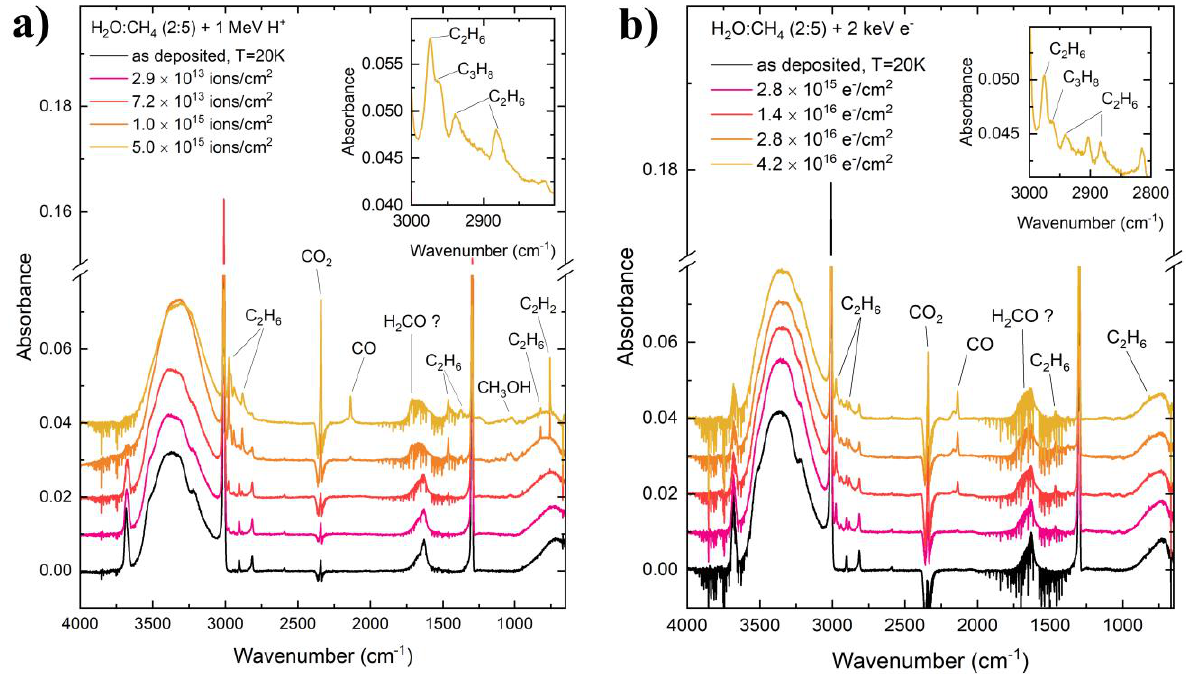
Figure 2. Mid-infrared absorption spectra of CH 4 :H 2 O (= 5:2) mixed ices upon preparation at 20 K and during irradiative processing using ( a ) 1 MeV protons and ( b ) 2 keV electrons. The absorption bands of various daughter molecules have been labelled. Note that the fine structures and negative absorptions in the regions of the H 2 O and CO 2 bands are due to variations in the concentrations of atmospheric gas-phase H 2 O and CO 2 in the pathlength leading to the detector, which is not maintained under vacuum.